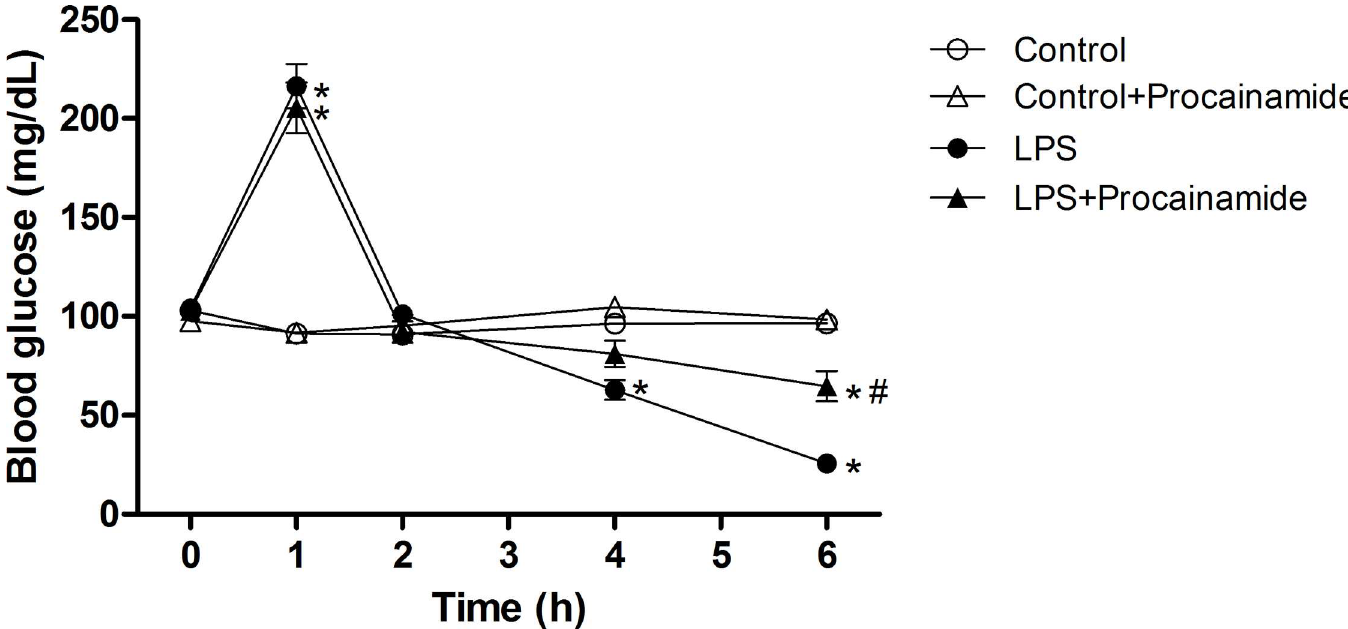
Fig 2. Effects of procainamide on blood glucose in endotoxemic rats. Depicted are the changes during the experimental period in different groups of animals that received saline at time 0 (Control, n = 8), received saline as in Control group and then received procainamide at 1 h (Control + Procainamide, n = 8), received LPS at time 0 (LPS, n = 10), and received LPS at time 0 and then received procainamide at 1 h (LPS + Procainamide, n = 10). Data are expressedas mean ± SEM. * P < 0.05, all versus Control rats; # P < 0.05, with versus without procainamide in LPS